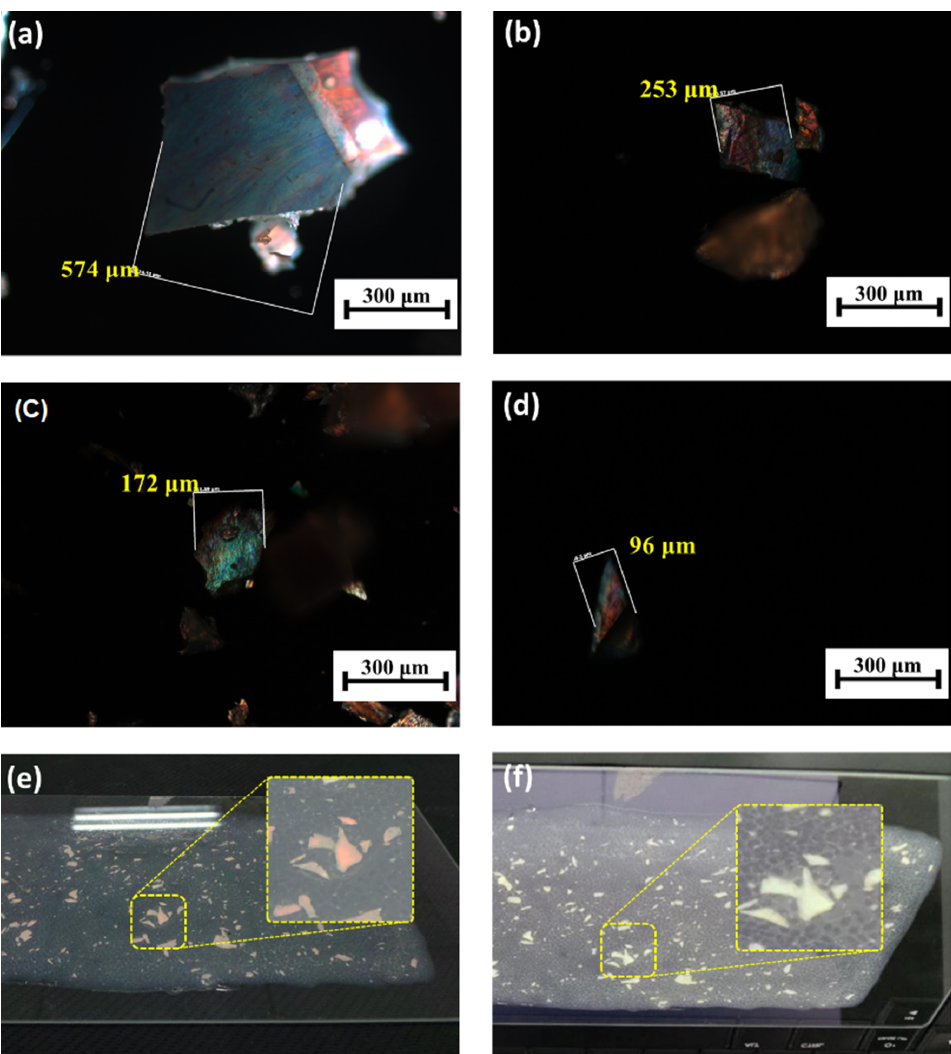
Figure 5. ( a–d ) Optical microscopic images of the powders made from the side-chain liquid crystal co-polymer 3HG2080; ( e , f ) photographs of the powder film from different viewing angles with enlarged pictures of the same area.